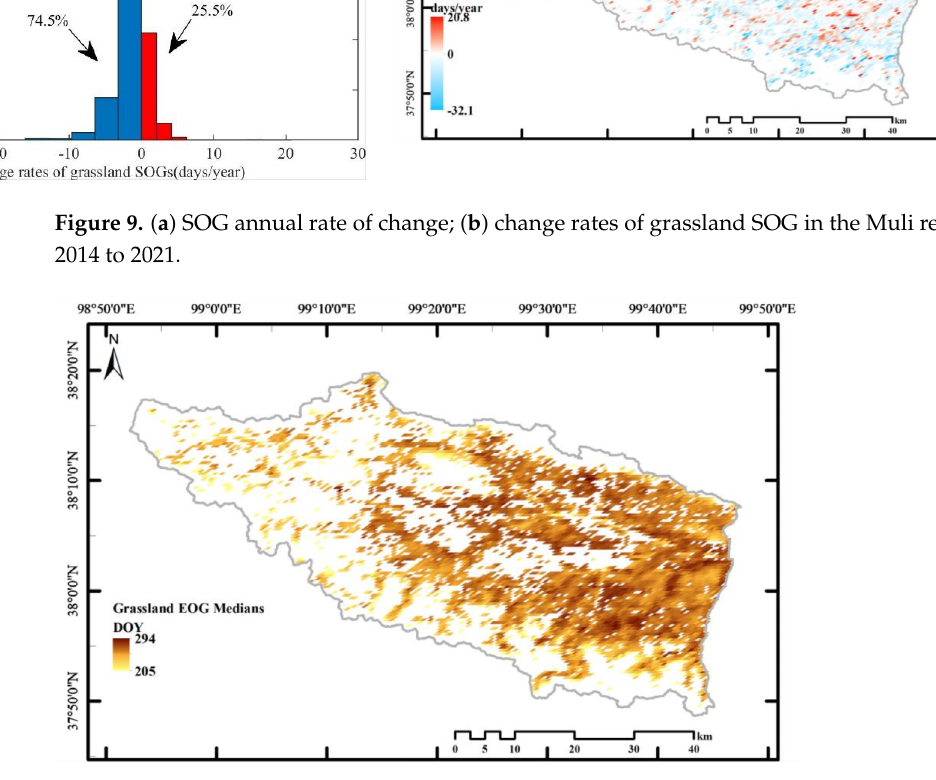
Figure 11. ( a ) EOG annual rate of change; ( b ) change rates of grassland EOG in the Muli region from 2014 to 2021. Figure 12 shows the distribution of mean LOG values from 2014 to 2021 for the Muli region, and Figure 13 shows the annual rate of change of LOG from 2014 to 2021 for the Muli region. The mean vegetation LOG values in the study area ranged from 71 – 161 days, with longer grass growth cycles in the east and south. Comparing the trends in SOG and EOG, it is clear that most (~80%) of the grassland vegetation within the mine area has become longer in LOG as a result of the overall trend of delayed EOG and earlier SOG. The lengthening rates were concentrated between 0 – 10 days/year.